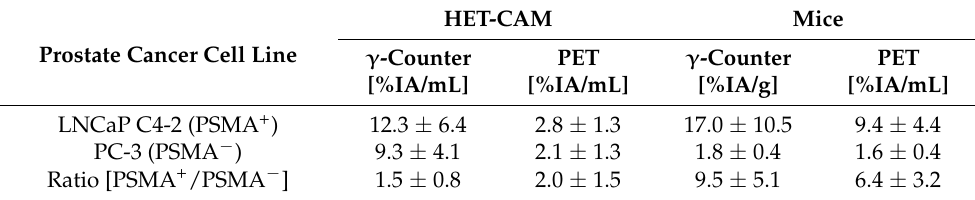
Table 1. Summary of the activity concentrations (mean ± standard deviation) in PSMA + and PSMA − tumor xenografts obtained with γ -counter and PET measurement for both in vivo models.